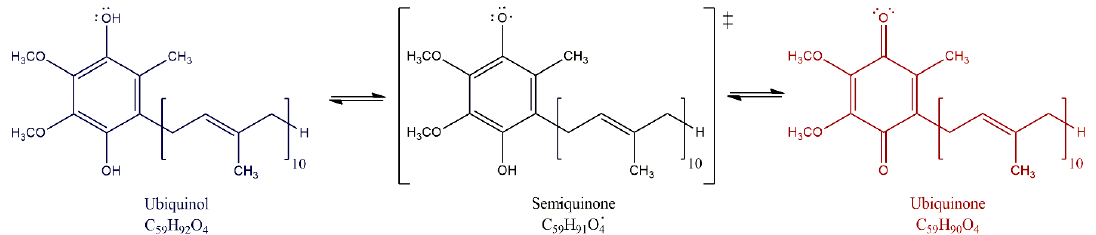
Figure 1. Redox forms of CoQ 10. ubiquinone (oxidized form), ubiquinol (reduced form), and semiquinone (semi-oxidized). The Q cycle within the matrix membrane allows proton transfer from the mitochondrial matrix to the intermembrane space helping to generate the electrochemical gradient for ATP production.